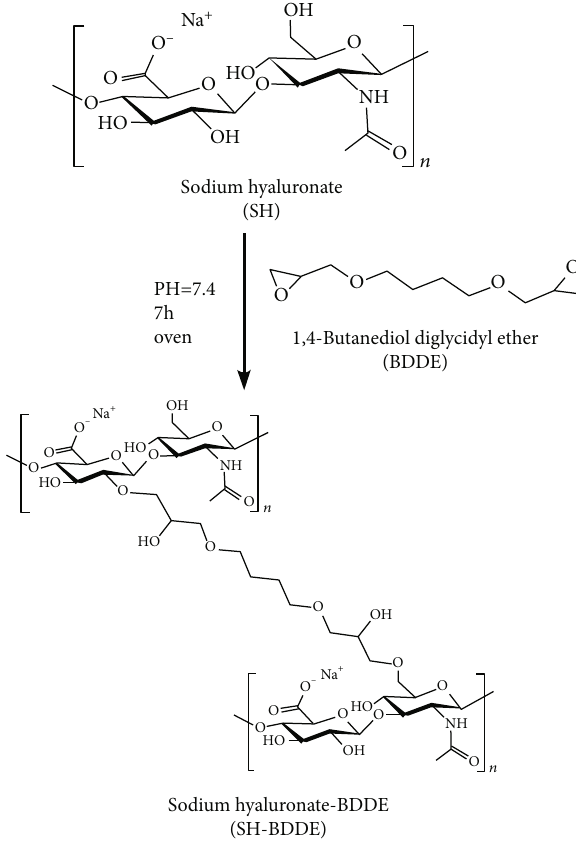
Figure 2: The reaction process of SH and